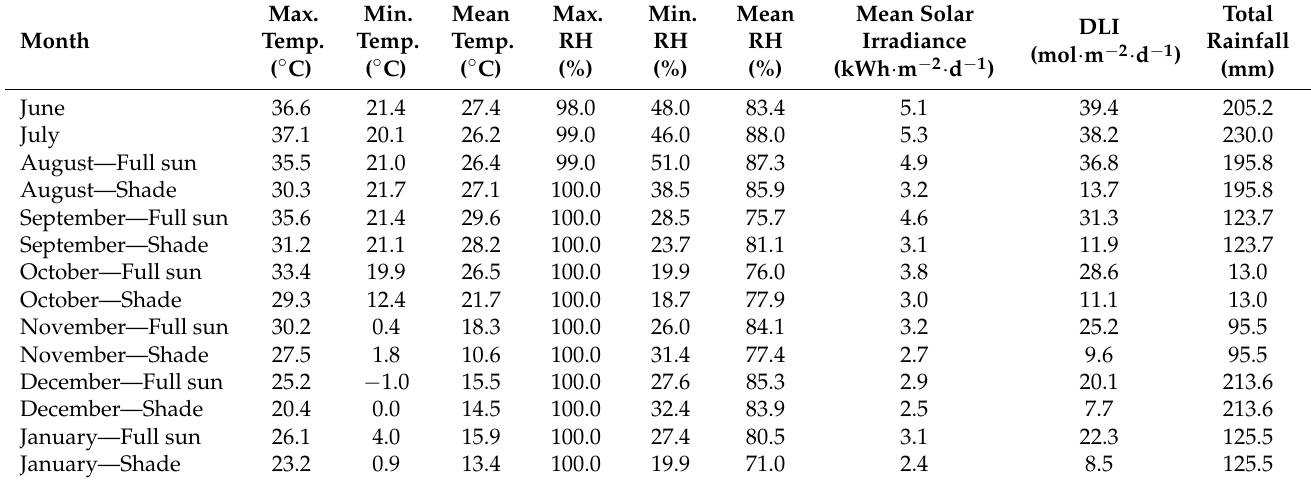
Table 1. Average monthly maximum (Max.), minimum (Min.), and mean air temperature (Temp.); relative humidity (RH); mean solar irradiance; daily light integral (DLI); and total rainfall